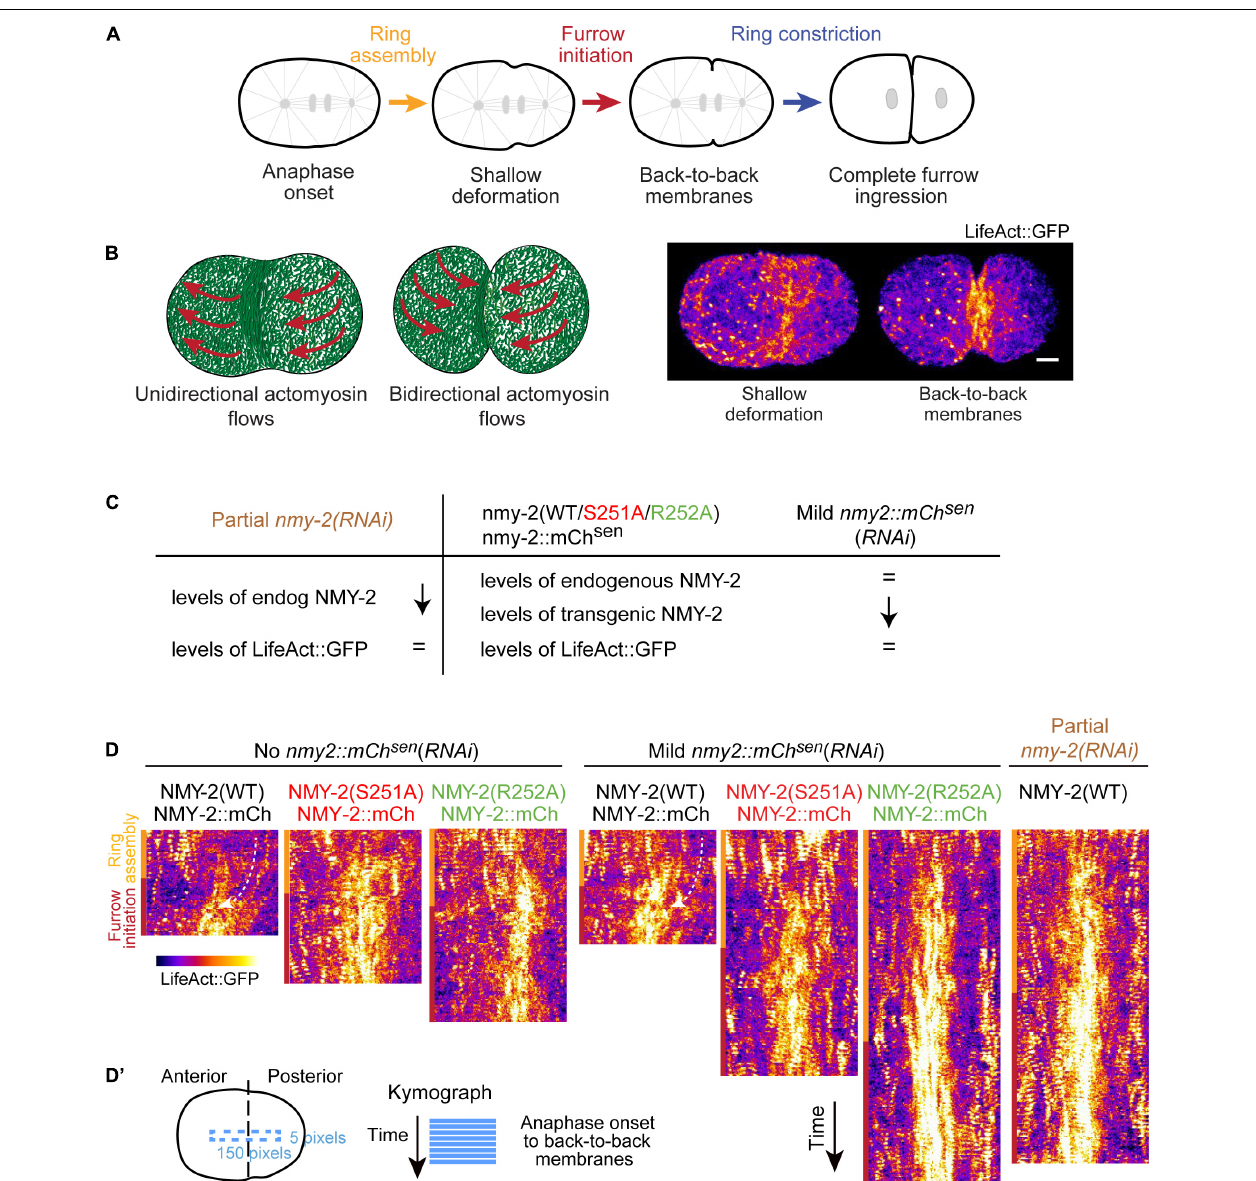
FIGURE 1 | Perturbation of myosin motor activity or reduction of myosin levels lead to significantly reduced cortical F-actin flows. (A) Schematic of cytokinesis. Reference points used for measurements of ring assembly and furrow initiation intervals are indicated. Ring assembly: time interval between anaphase onset and the formation of a shallow equatorial deformation, when contractile ring components are being recruited to the cell equator. Furrow initiation: time interval between shallow deformation and the folding of the plasma membrane into a back-to-back configuration. Ring constriction: time interval between back-to-back membrane configuration and full furrow ingression. (B) Stills of cortical images of an embryo expressing LifeAct::GFP at shallow deformation and furrow initiation with a schematic illustrating the transition from unidirectional cortical flows during ring assembly to bidirectional flows starting at the onset of ring constriction. (C) Perturbations used and their effect on the levels of endogenous and transgenic NMY-2 and LifeAct::GFP relative to controls with no RNAi, as described in Osorio et al. (2019). (D) Kymographs of LifeAct::GFP cortical flows along the longitudinal axis in one-cell embryos for the conditions indicated in (C) . Yellow and red bars correspond to ring assembly and furrow initiation time intervals, respectively. Curved arrows indicate posterior-anterior flow direction. (D’) Schematic illustrating the region of the embryo used for the kymographs in (D) . Scale bar, 5 µ m.